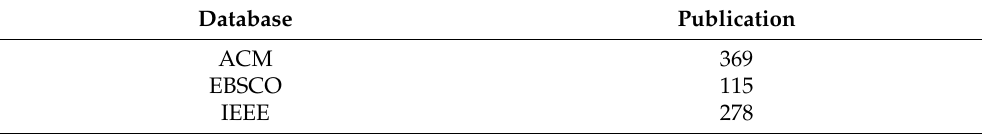
Table 2. The number of publications results after the application of exclusion